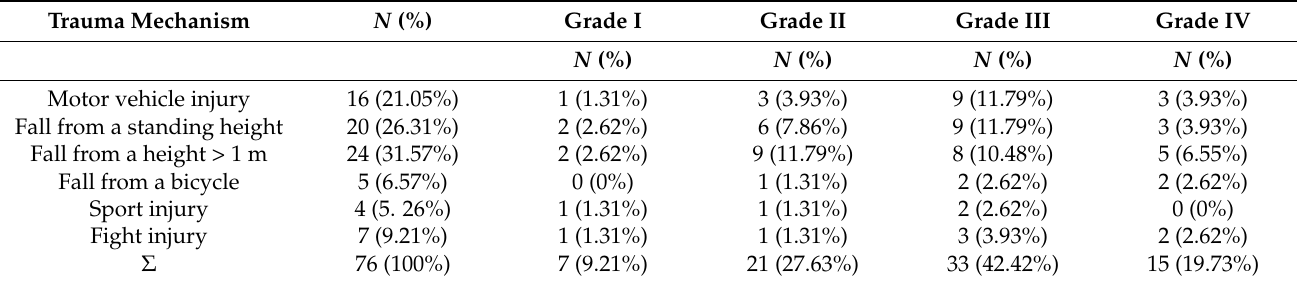
Table 2. The distribution of splenic injury grade (AAST classification) according to mechanism of trauma. Trauma Mechanism